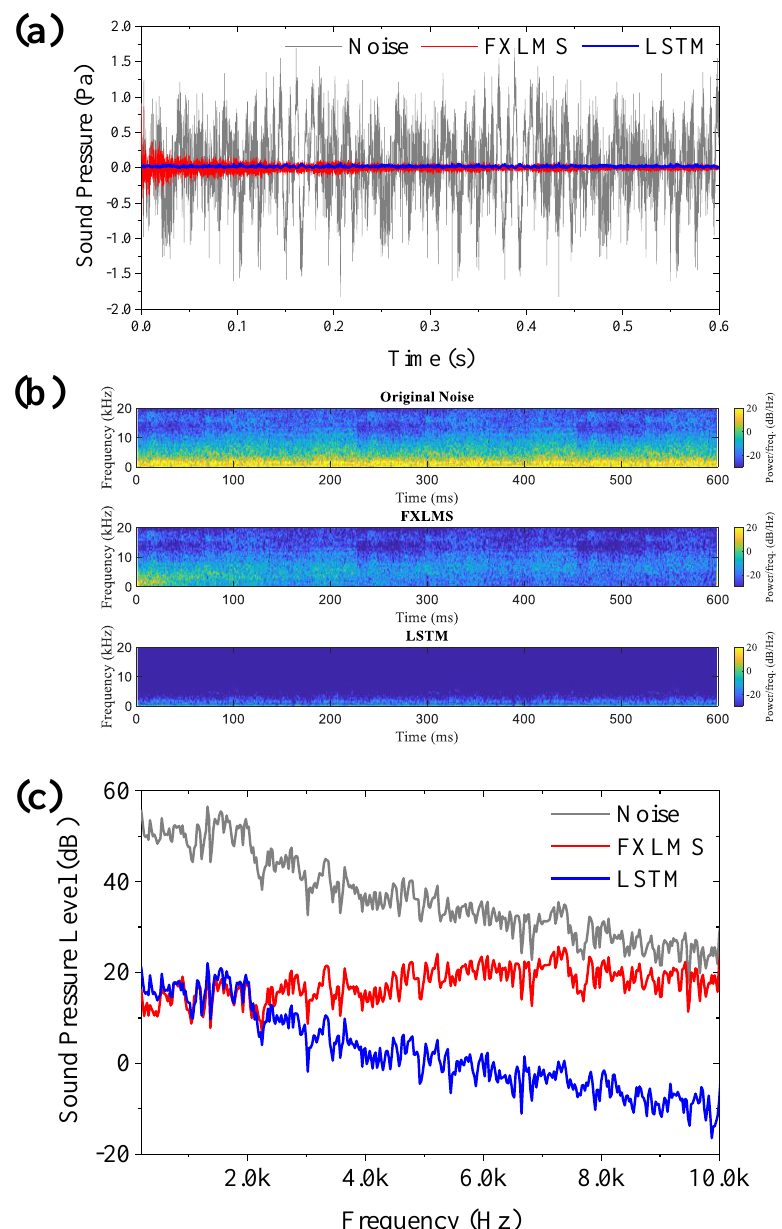
Figure 6. ANC simulation result using FxLMS and LSTM for superposed harmonic sounds with main frequencies of 33, 35, 50, and 60 Hz measured from diesel engines. ( a ) Time data of diesel engine noise and ANC results; ( b ) short-time Fourier transform analysis of original noise and noise residue; ( c ) power spectral density of the diesel engine noise and ANC result in the period when the error signal is minimized.